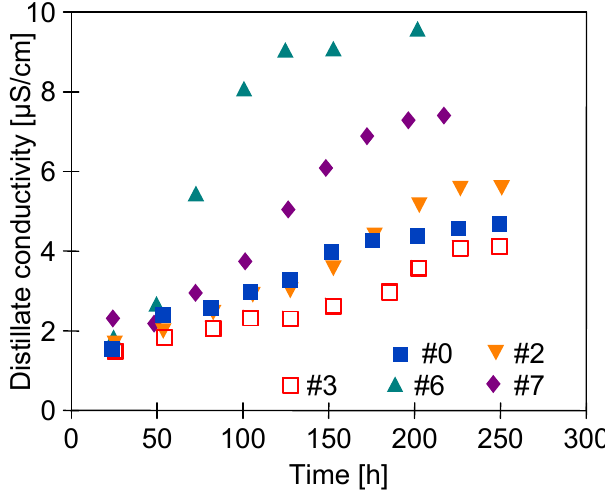
Figure 11. Changes in distillate electrical conductivity during the MD process (Figure 10). One year after plasma treatment.